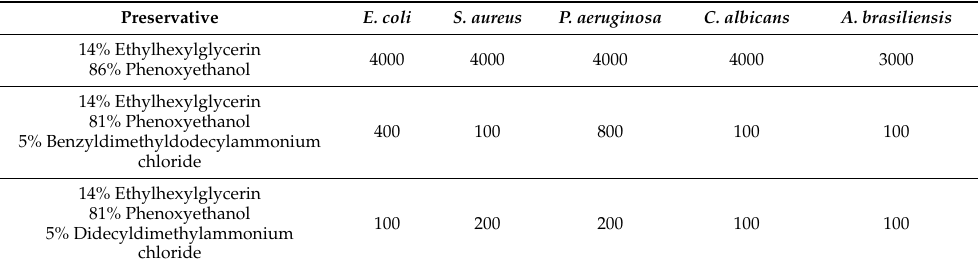
Table 2. MIC values (expressed in ppm) of Ethylhexylglycerin and Phenoxyethanol mixture and with addition of 5% Benzyldimethyldodecylammonium chloride or 5% Didecyldimethylammonium chloride cationic surfactants. Preservative